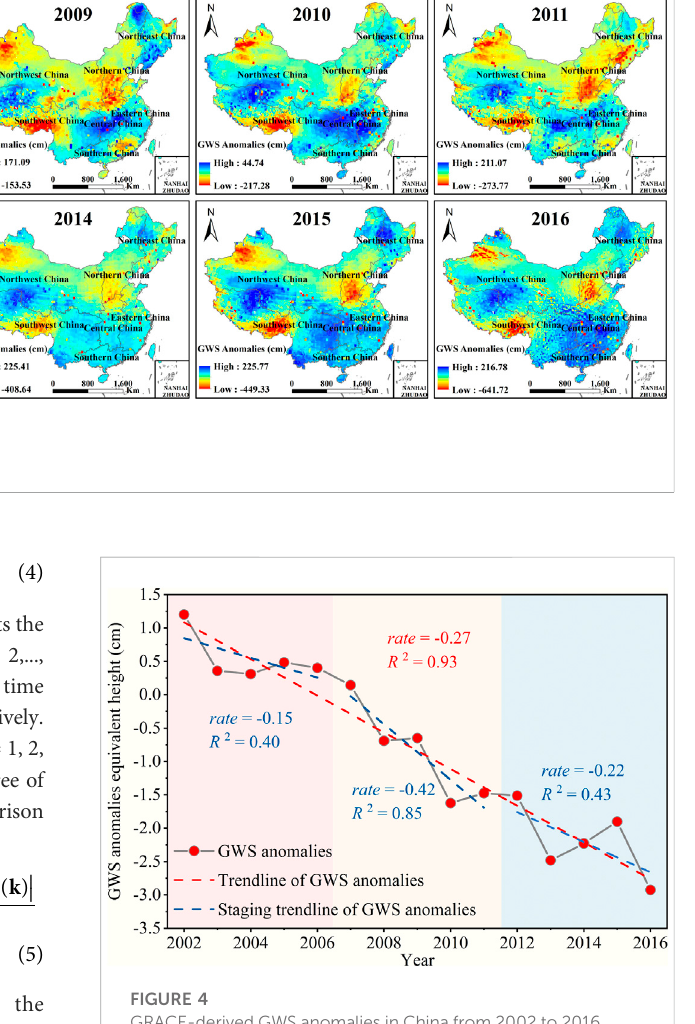
FIGURE 4 GRACE-derived GWS anomalies in China from 2002 to